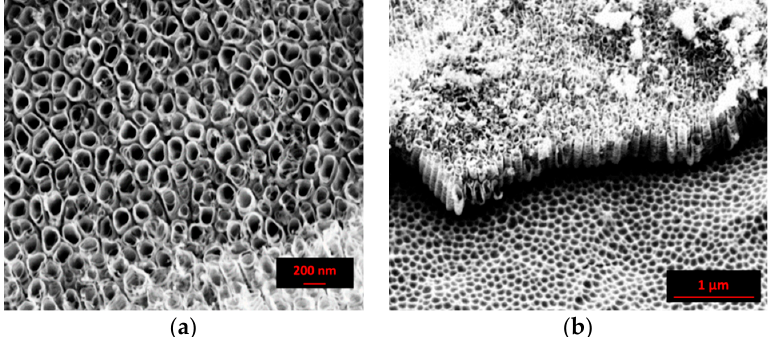
Figure 2. SEM images of the anodized sample in the “inorganic” solution at 30 V for 90 min: ( a ) top view and ( b ) cross sectional view. X-Ray diffractometry. Table 2. Geometric features of titanium nanotubes formed in the inorganic, Ti_NT inorg , or in the organic electrolyte, Ti_NT org .